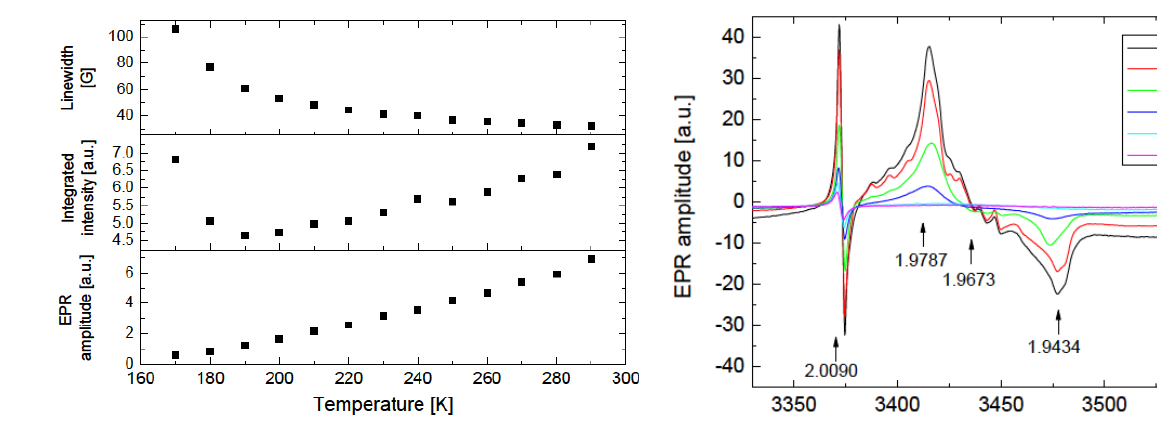
Figure 14: Temperature dependence of the linewidth (top panel), integrated intensity (middle panel), and signal amplitude (bottom panel) for the BHT component in B-800 sample.